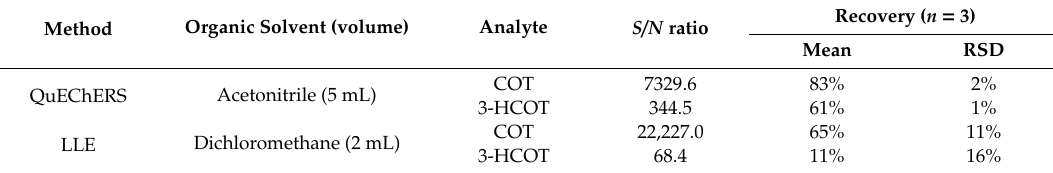
Table 3. Comparison of the proposed method with the previous LLE method [11].